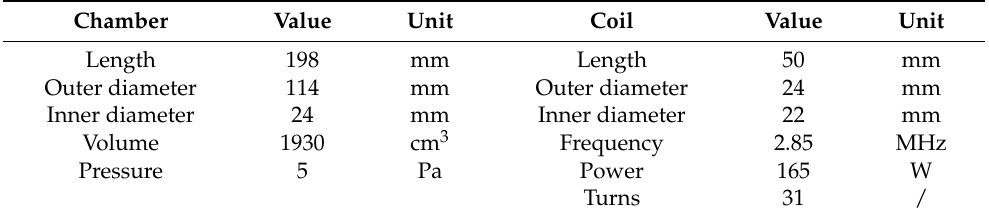
Table 1. Parameters of the ICP